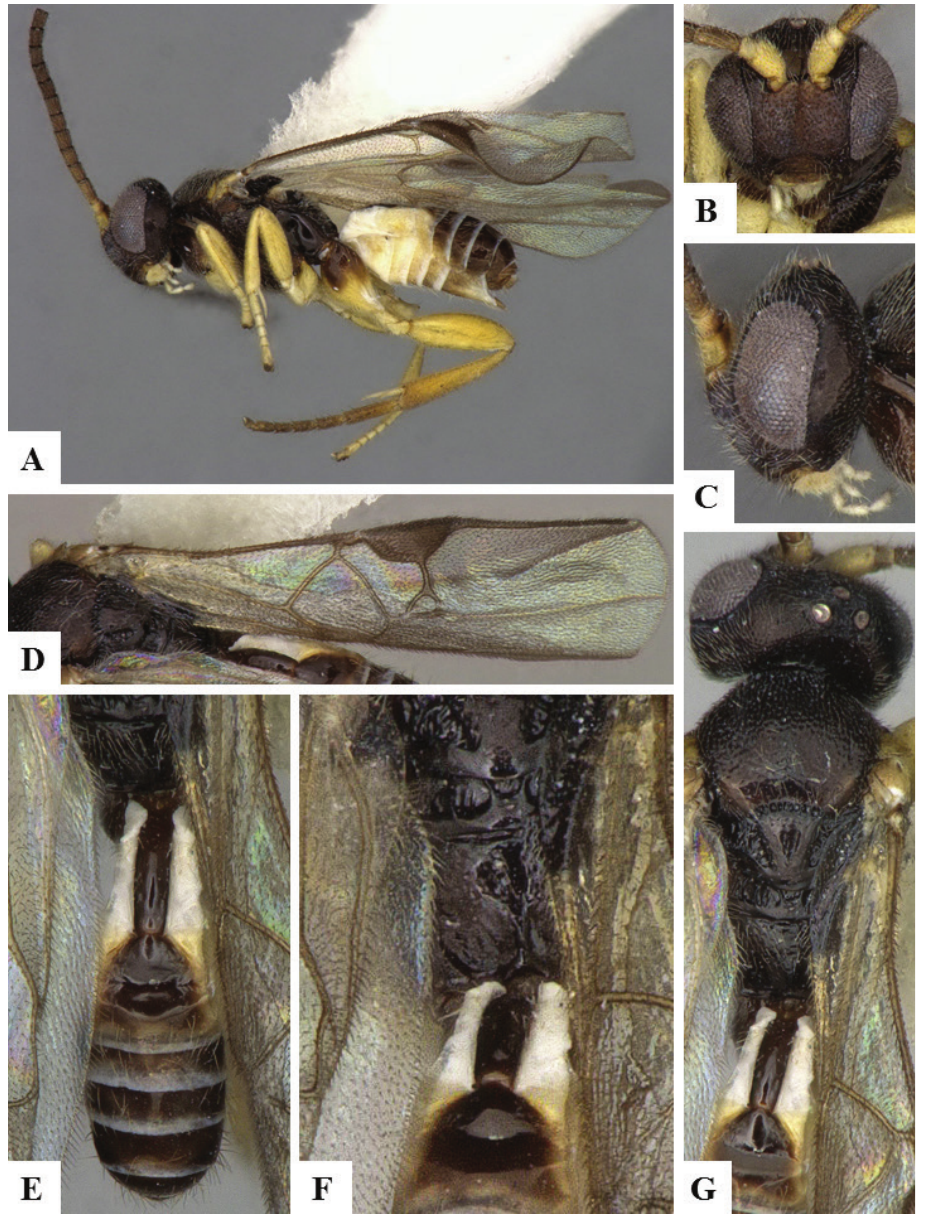
Figure 29. Markshawius francescae female holotype. A Habitus B Head frontal C Head lateral D Fore wing E Metasoma dorsal F Propodeum G Mesosoma